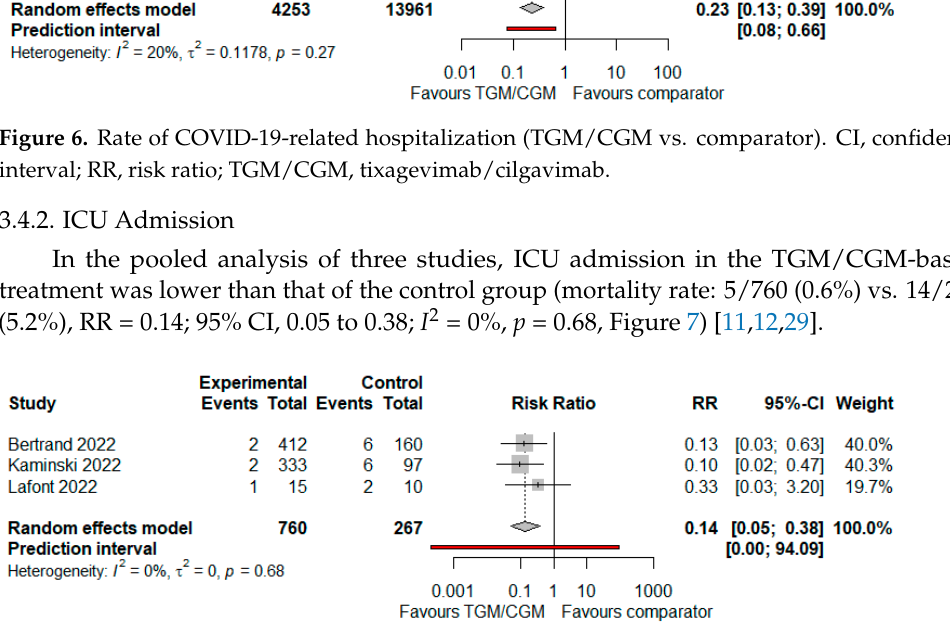
Figure 8. Rate of mortality (TGM/CGM vs. comparator). CI, confidence interval; RR, risk ratio; TGM/CGM, tixagevimab/cilgavimab. 3.4.4. Neutralization of COVID-19 Omicron Variant In the pooled analysis of two studies, the rate of patients with neutralization of the COVID-19 Omicron variant in the TGM/CGM-based treatment was higher than that of the control group (rate of neutralization of COVID-19 Omicron variant: 16/124 (12.9%) vs. 6/100 (6%), RR = 2.25; 95% CI, 0.91 to 5.60; I 2 = 0%, p = 0.60, Figure 9) [21,26]. Figure 9. Rate of neutralization of COVID-19 Omicron variant (TGM/CGM vs. comparator). CI, con- fidence interval; RR, risk ratio; TGM/CGM, tixagevimab/cilgavimab. 3.4.5. Need for Oxygen Therapy In the pooled analysis of two studies, the proportion of patients who needed oxygen therapy in the TGM/CGM-based treatment was lower than that of the control group